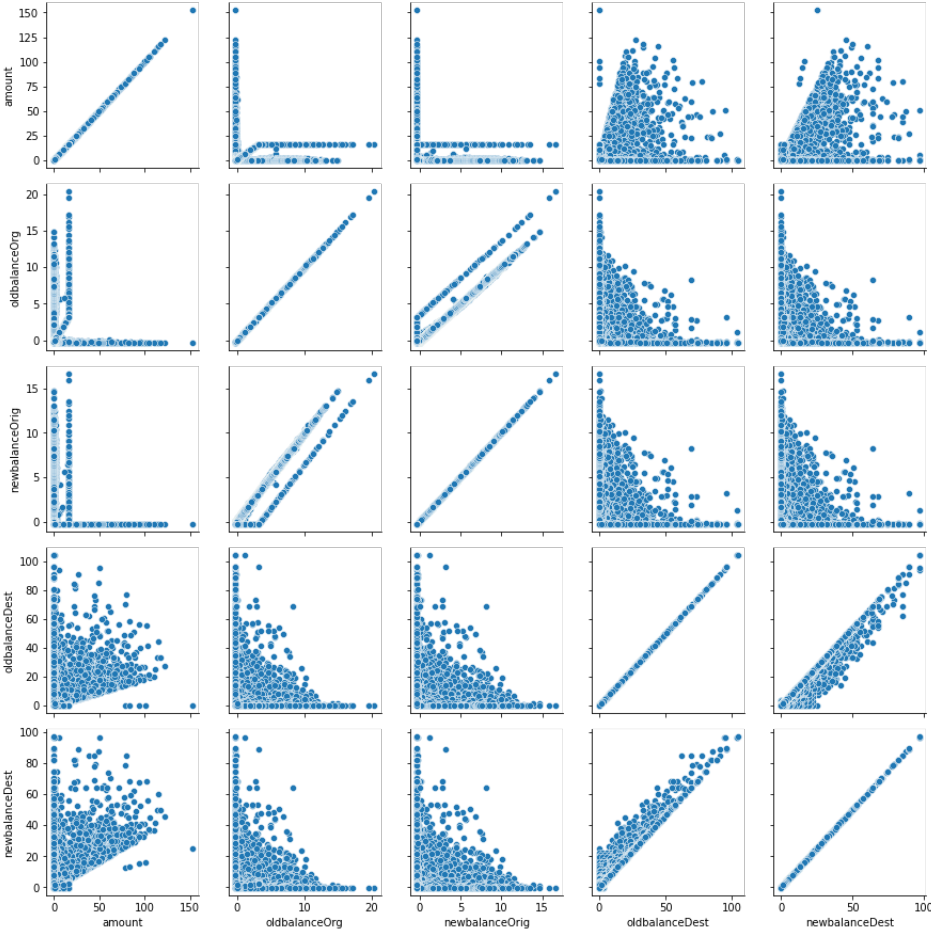
Figure 3. Scatter density plot for features of the dataset.